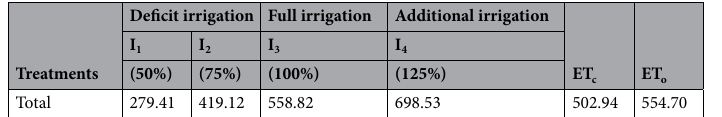
Deficit irrigation Full irrigation Additional irrigation Treatments